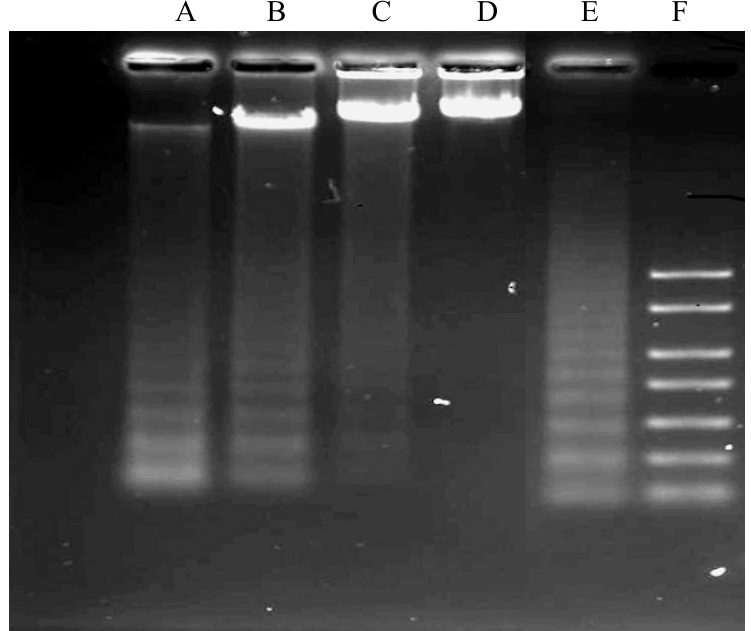
Figure 5. Effects of Thymoquinone on DNA fragmentation in CEMss cells. (Lanes A–D were treated with 1.5 µg/mL. Lane E: positive control and lane F: marker). Figure shows data representative of three independent